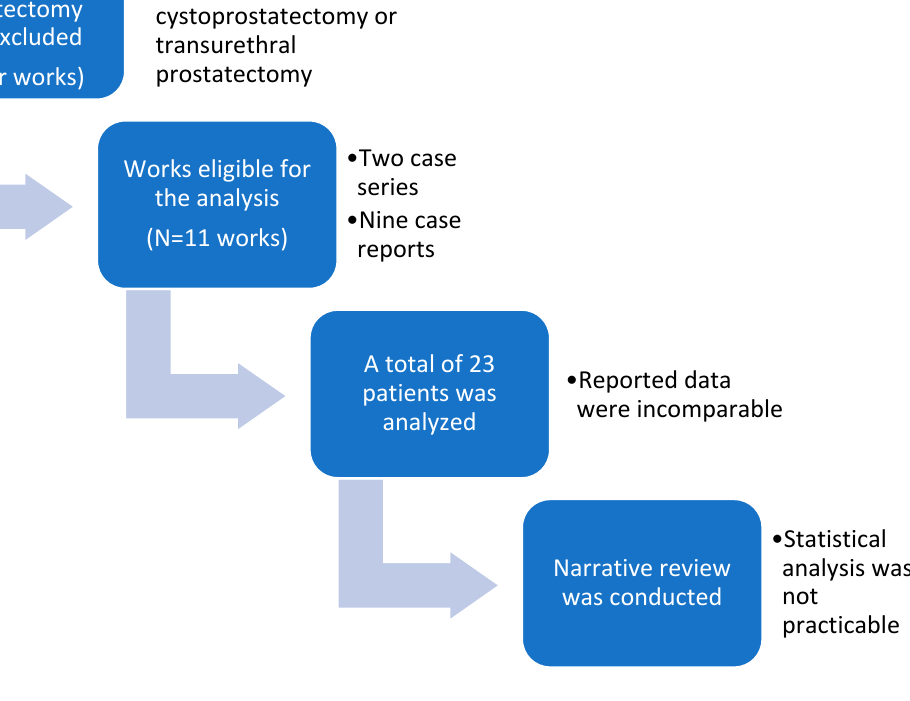
Figure 5. Scheme of the review.